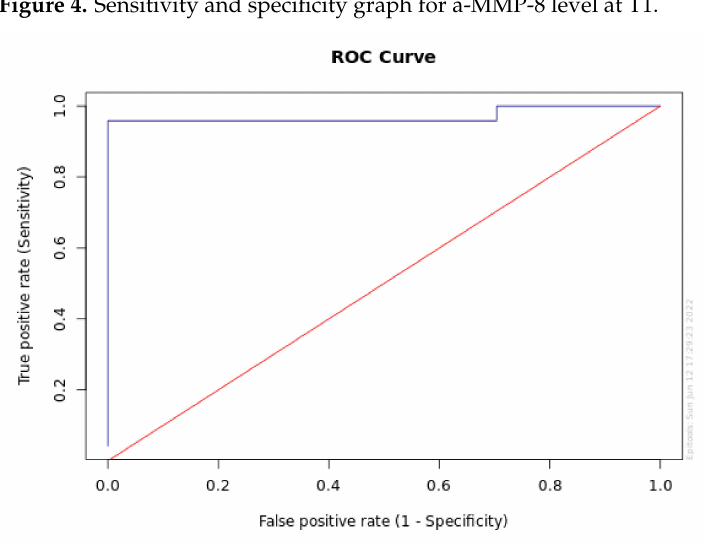
Figure 5. Area under the ROC curve for a-MMP-8 at T1 (95% CI for AUC). The results indicated that a cutoff point of 15.3 ng/mL for a-MMP-8 has the distinct ability to predict the onset of P+ at 5